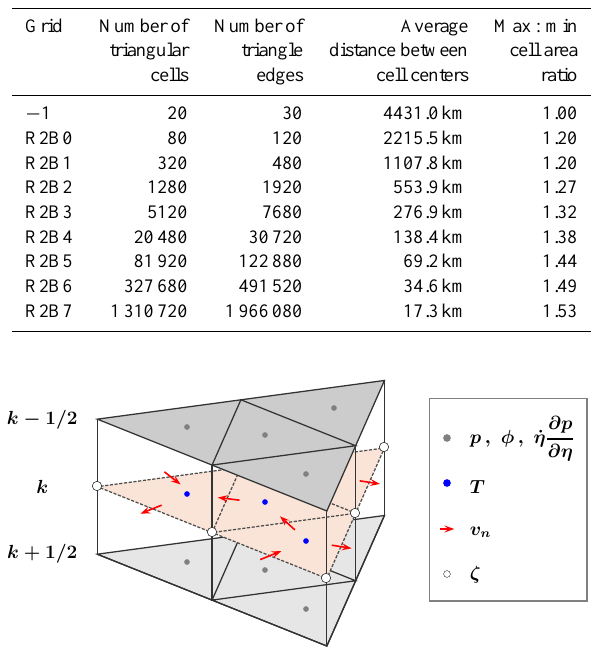
Fig. 1. Illustration of the triangular grid and the location of main variables. Vertical level indices are shown to the left of the sketch. The meaning of the symbols can be found in Sects. 2 and